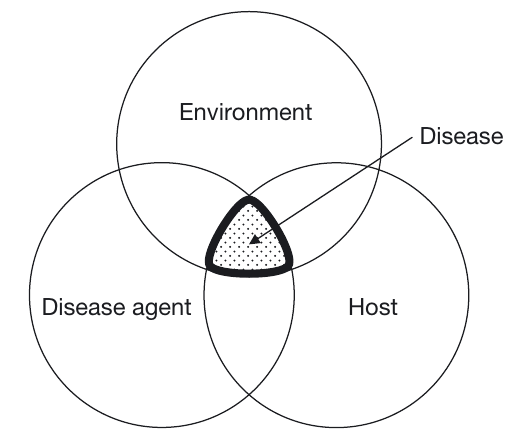
Fig. 2. Simple disease triangle demonstrating the relation- ships among host, disease agent and environment in